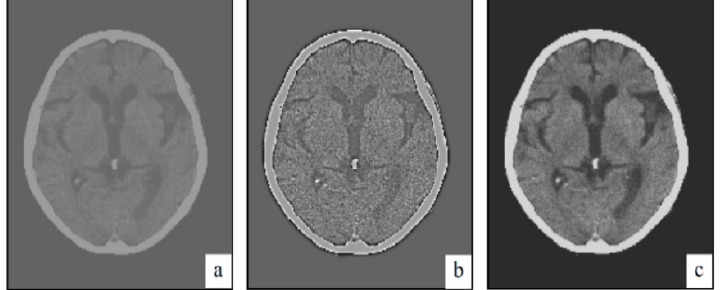
Figure 6. ( a ) Initial, low contrast image. ( b ) Scaled image. ( c ) Enhanced image.